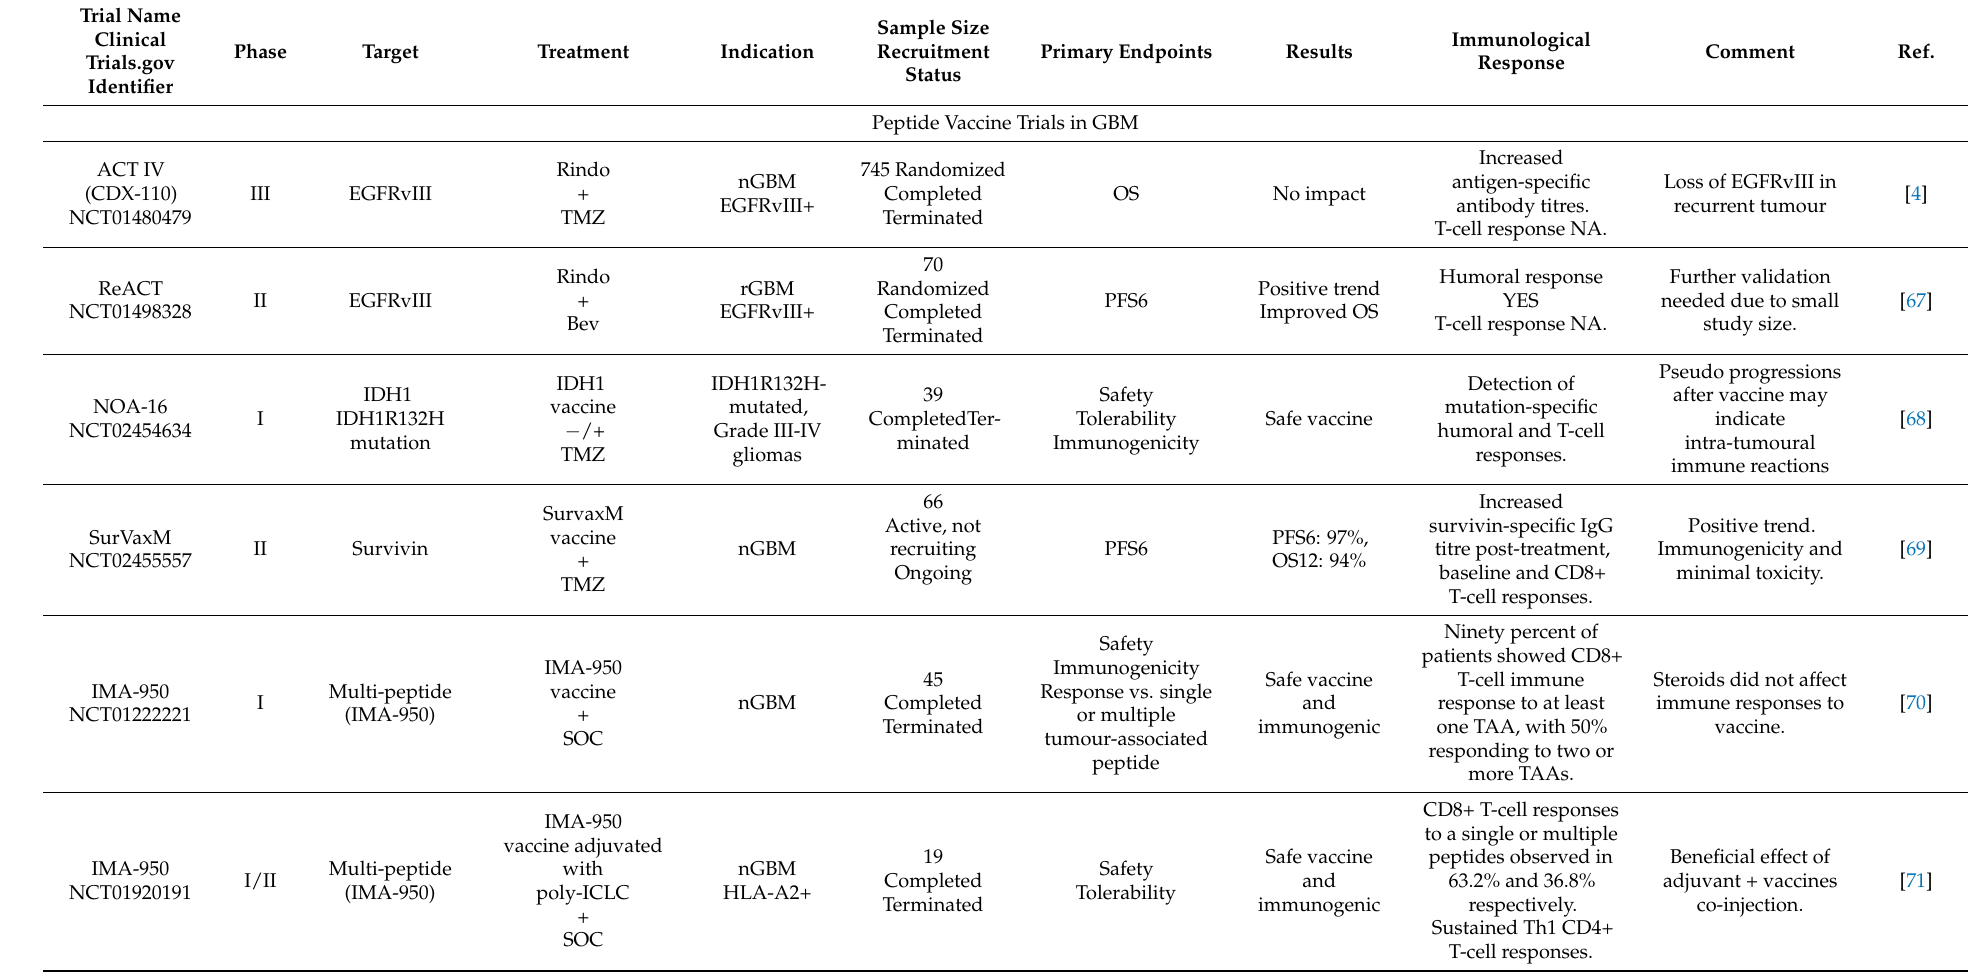
Table 2. Overview of the vaccine and heat-shock protein peptide complex in 96 clinical trials and in